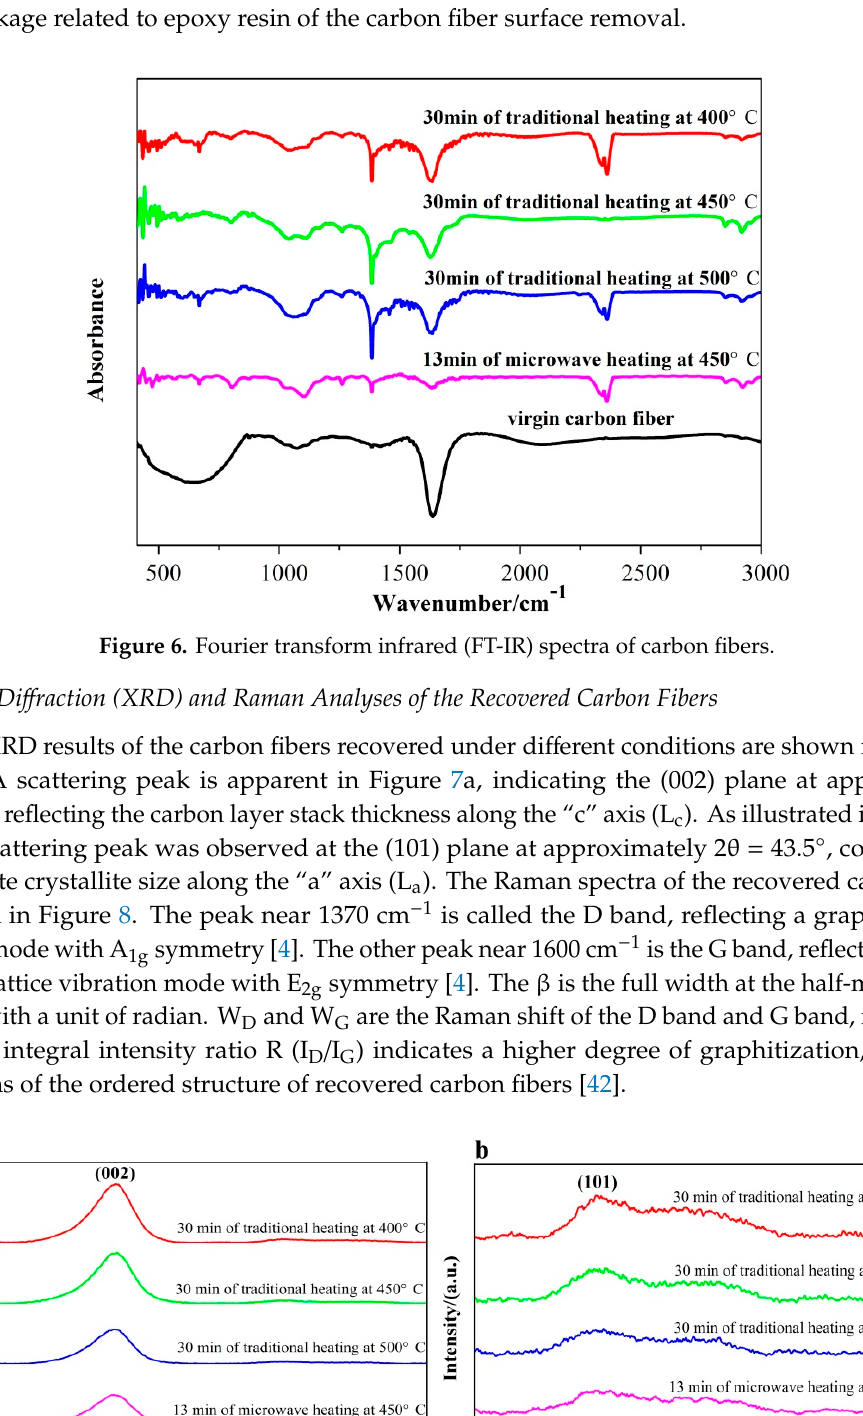
Figure 8. Raman spectra of carbon fibers. Table 2 contains the crystallite parameters of the (002) plane and the (101) plane of the recovered carbon fibers in the XRD analysis. Upon comparison of carbon fibers which were recovered using the traditional method from 400 °C to 500 °C for 30 min, the value of β increased with increasing reaction temperature, which means the width of the scattering peaks increased, possibly due to the decrease in the crystallite size of the carbon fibers [43]. The intensity of the scattering peaks weakened significantly with increasing reaction temperature, indicating a reduction in the degree of graphitization. Comparison of the crystallite sizes (L c and L a ) of the carbon fibers which were recovered using the traditional method from 400 °C to 500 °C showed that the size decreased obviously with an increase in temperature, revealing that the amount of amorphous carbon increased, demonstrating a lesser degree of graphitization and lower carbon fiber strength. This result was consistent with the conclusion obtained from Figure 7. Upon comparison of Samples 2 and 4, microwave heating had less influence on the degree of graphitization of recovered carbon fibers at 450 °C, due to the very similar values of L c , and L a . Compared with virgin carbon fibers, the properties of recycled carbon fibers decreased slightly. We believe that the reduction of graphitization is due to the increase of amorphous carbon, and the increase of amorphous carbon is due to temperature, and may also be the result of the intensified carbon combustion. In this study, we found this phenomenon, but the relationship between the decrease of graphitization degree, increase of amorphous carbon, temperature factor and carbon combustion still need to be further studied.